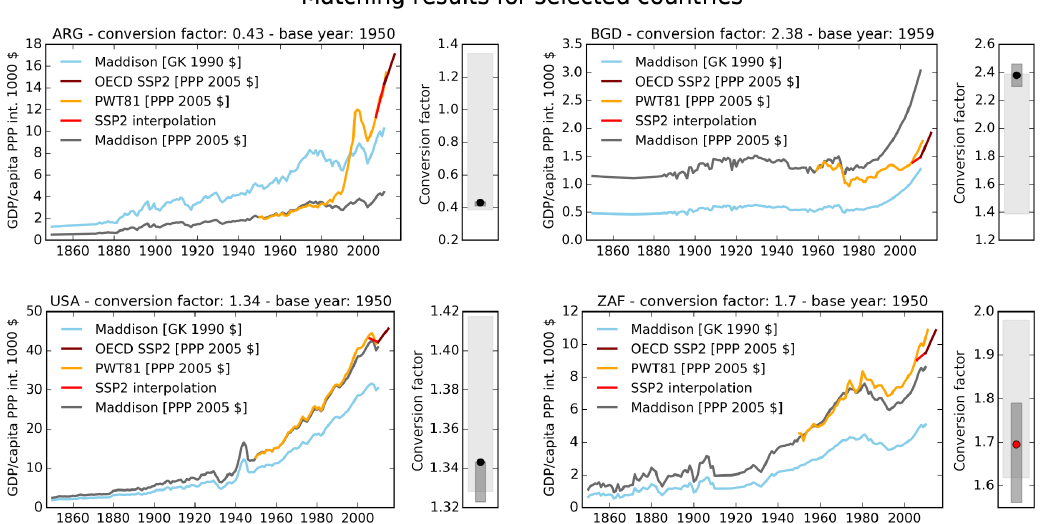
Figure 4. Results of matched GDP per capita time series for Maddison, PWT, and OECD SSP2 data for selected countries: ARG: Argentina; BDG: Bangladesh; USA: United States of America; ZAF: South Africa. Original Maddison data (blue, in 1990 GK USD) are matched to PWT data (yellow, in 2005 PPP USD) using a country-specific base year and conversion factor, to obtain converted Maddison data (gray, in 2005 PPP USD). Between 2006 and 2009, PWT data are interpolated (red) to match OECD SSP2 projections (maroon) starting in 2010. The sensitivity of the conversion factor over time is displayed to the right of each income time series. The black (red) point indicates whether the selected conversion factor was chosen based on the first overlapping year (5-year mean), while the dark gray and light gray shaded areas show the conversion factor min/max range for the first 5 overlapping years and for the 5-year running mean between the base year and 2005, respectively.